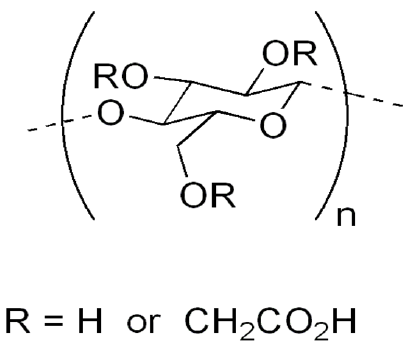
Figure 2. Carboxymethyl